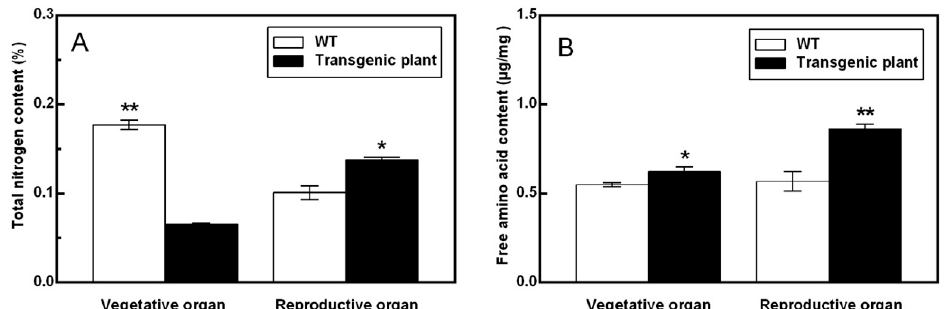
Figure 5. Contents of total nitrogen ( A ) and free amino acids ( B ) in vegetative (roots, and stems, and leaves) and reproductive (flowers and siliques) organs of wild-type (WT) and transgenic plants of Arabidopsis thaliana with overexpression of AtAAP1 . Symbols “*” and “**” indicate significant differences at p values of 0.05 and 0.01, respectively.